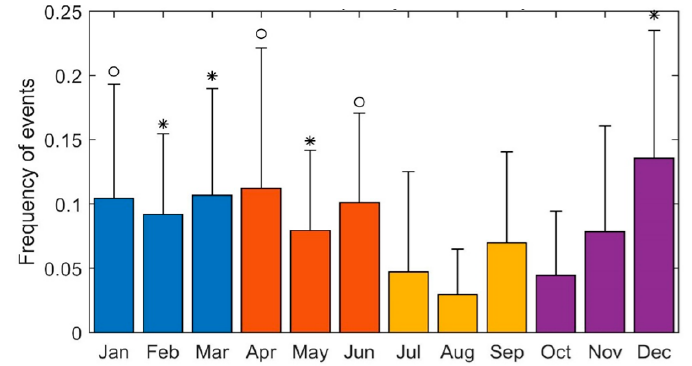
Figure 3. Seasonal distribution of the events. Bars: number of events, averaged across years. Whiskers: standard errors. p -values (Wilcoxon signed-rank test) assessing the difference between number of events registered during winter, spring and autumn with respect to those recorded during the summer (REF) are shown. p < 0.05 is reported in bold.